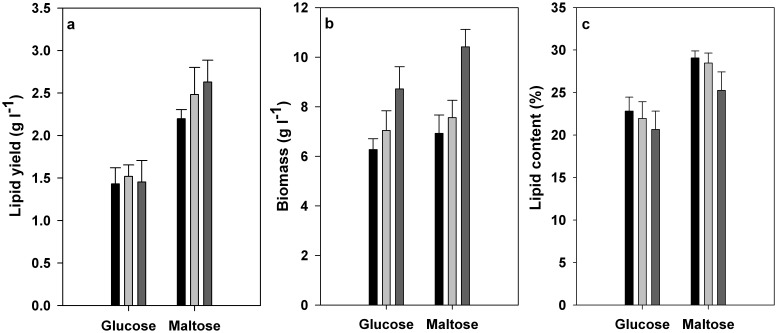
The lipid production (A, C) and cell growth (B) of A2-2 (black column), D1-B1 (gray column) and wild-type A-4 (dark gray column) in SmF experiments using glucose and maltose based media, respectively.